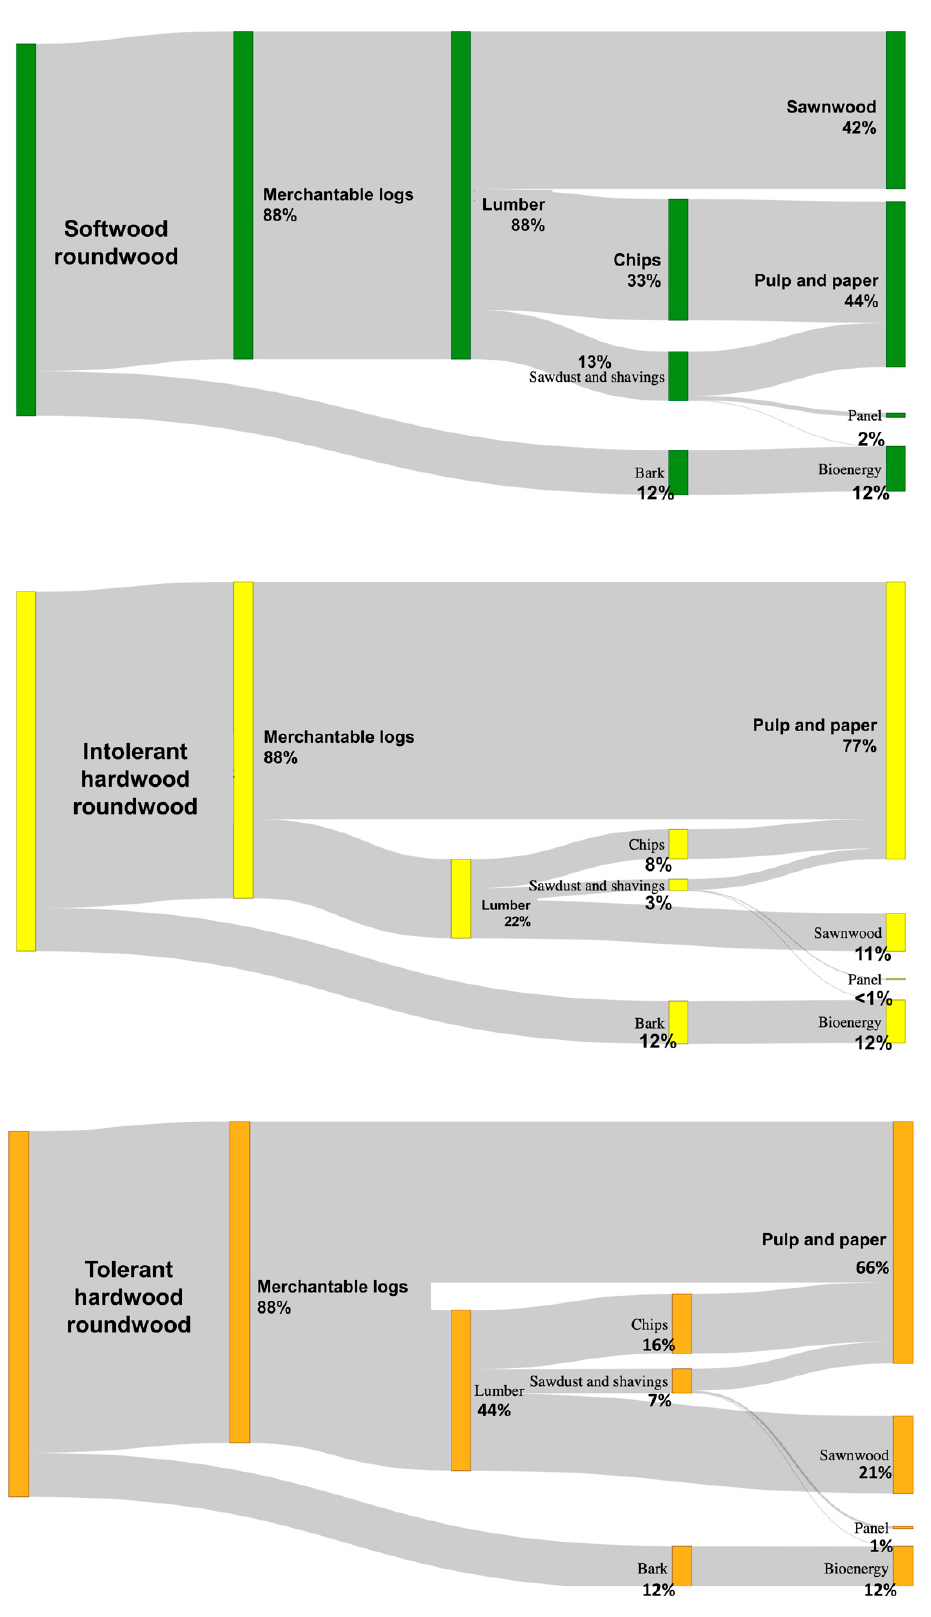
Figure 3. Parameters of the basket of wood products used for the distribution of harvested wood in the ecosystem-based forest management scenario. See Table 1 for the list of species. Bioenergy refers here to bio-heat used internally within sawmills.